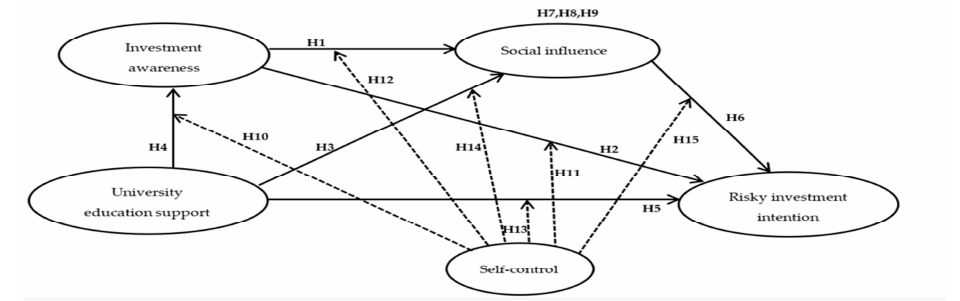
Figure 1. The theoretical mediating-moderating model.